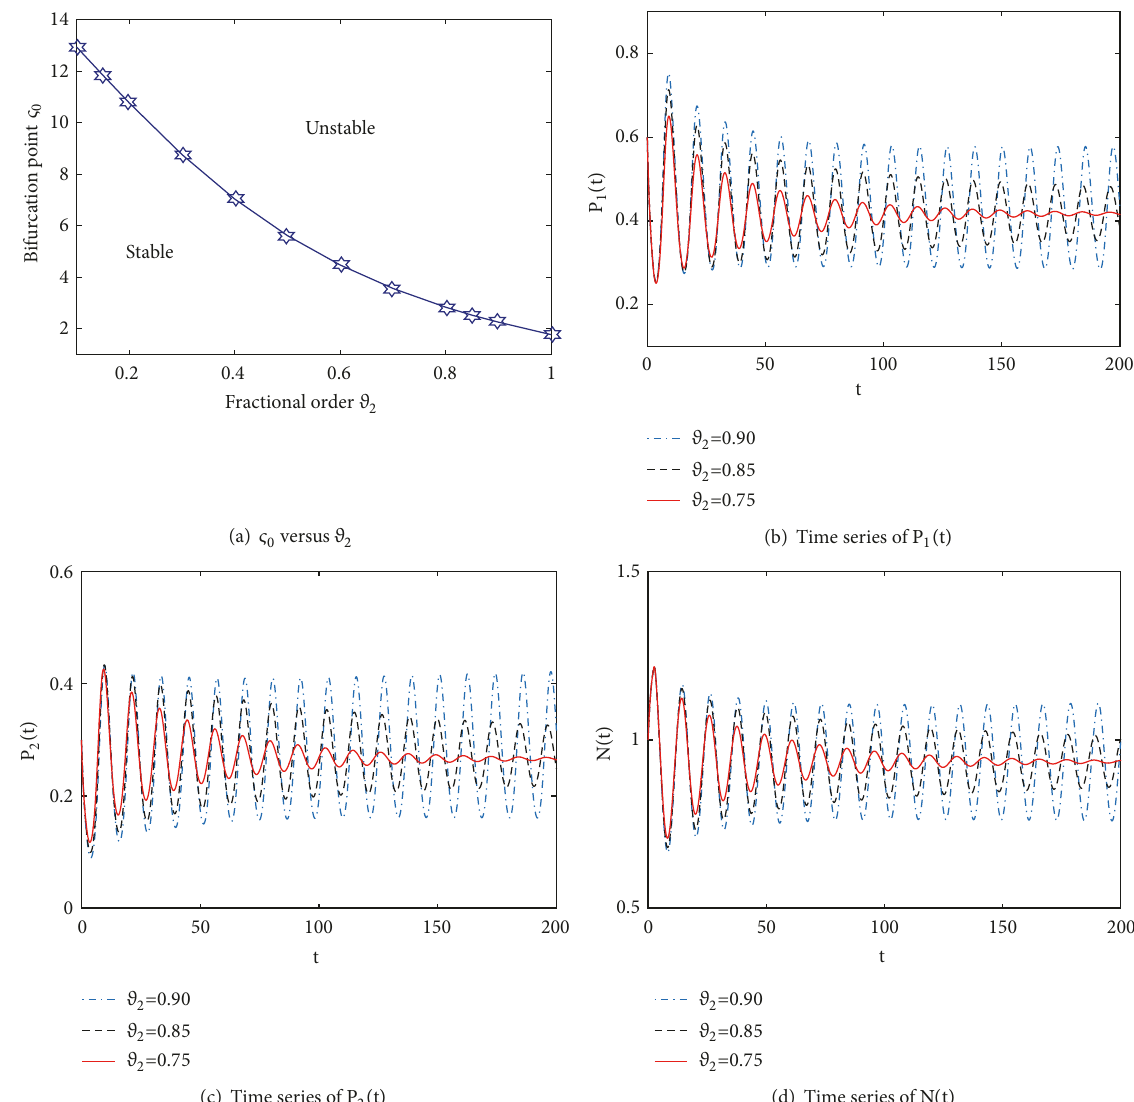
Figure 6: The impact of 𝜗 2 on the dynamical behaviors with 𝜗 1 = 0.85 and 𝜗 3 = 0.98 . Bifurcation value 𝜍 0 is negatively related to 𝜗 2 which is shown in (a) and numerical simulation validates the theoretical results which is shown in (b)–(d).